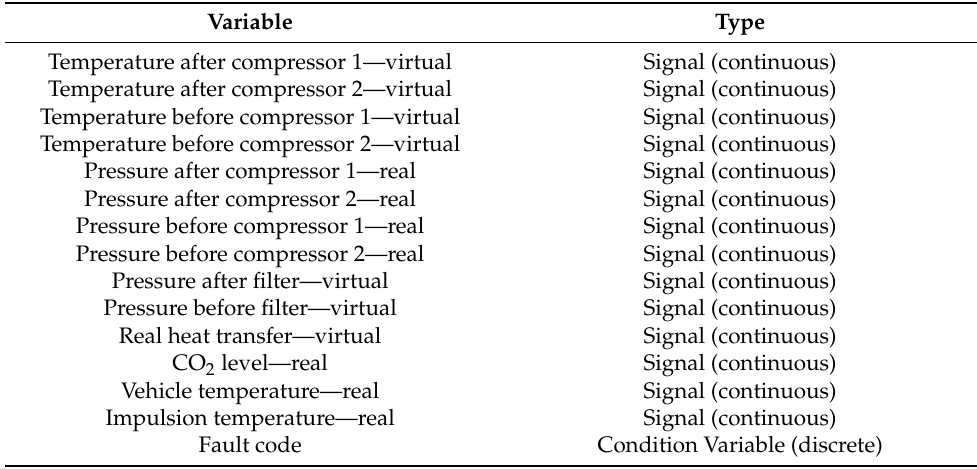
Table 1. List of sensors used to develop the hybrid model.